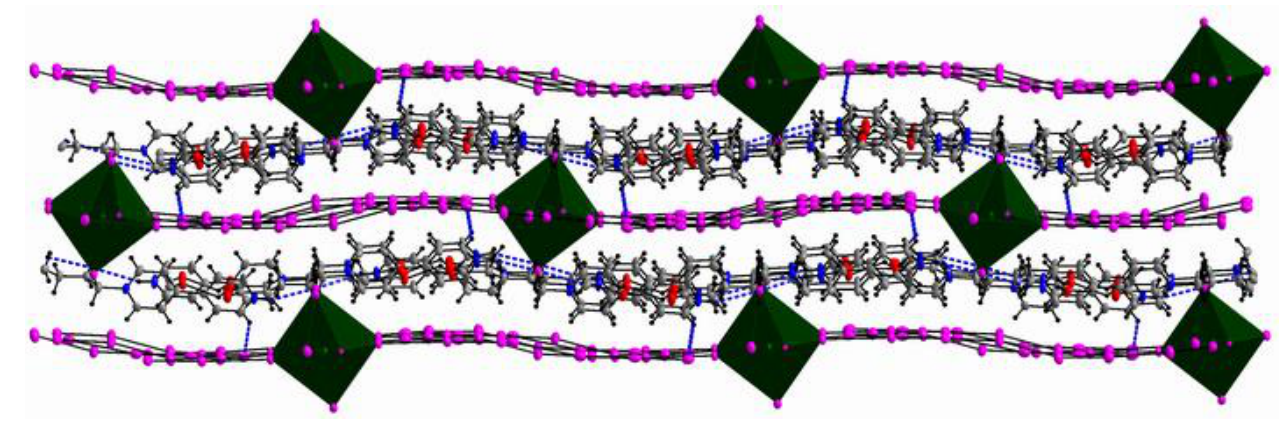
Figure 2. Quasi-3-D network of 1 based on I···I contacts and hydrogen bonds. Table 1. Selected Bond Lengths (Å ) and Bond Angles (°). Bond Dist. Bond Dist. Dist. Dist.